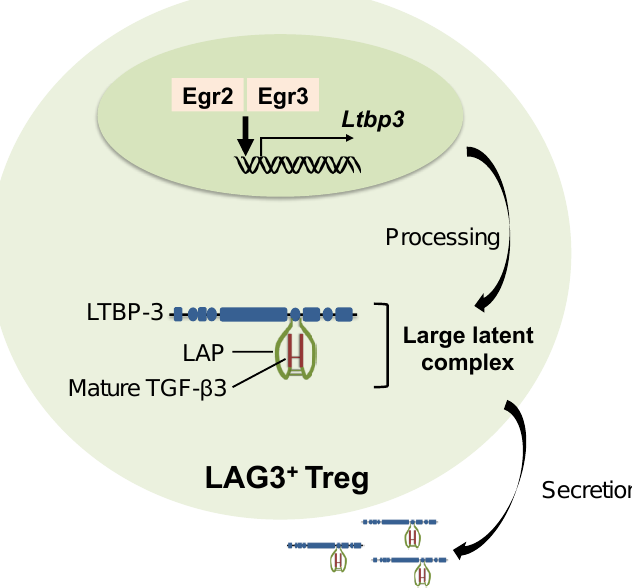
Figure 1. The roles of Egr in TGF- β 3 production in CD4 + CD25 − LAG3 + regulatory T cells. Synthesized latency-associated peptide (LAP) and mature TGF- β 3 binds to latent TGF- β binding protein-3 (LTBP-3), and the large latent complex is secreted from cells. Early growth response gene 2 (Egr2) and Egr3 regulate the expression of Ltbp3, which leads to efficient secretion of TGF- β 3 from CD4 + CD25 − LAG3 + regulatory T cells (LAG3 + Tregs).